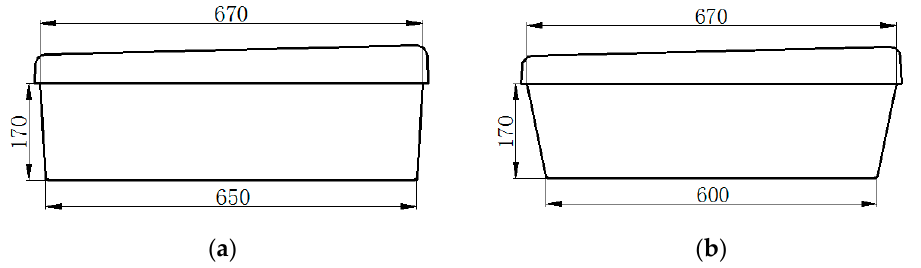
Figure 7. Comparison of geometric shapes of TLVT and ILVT. ( a ) TLVT elastic support block size. ( b ) ILVT elastic support block size.